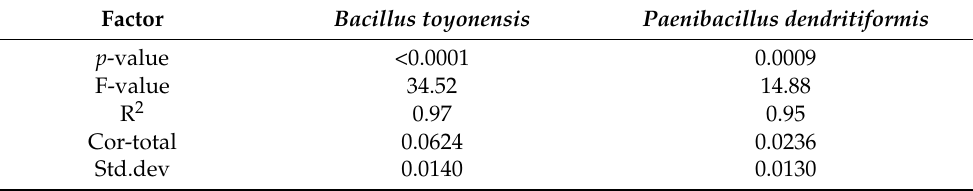
Table 4. ANOVA of Quadratic model for the release of nitrite during RDX degradation.